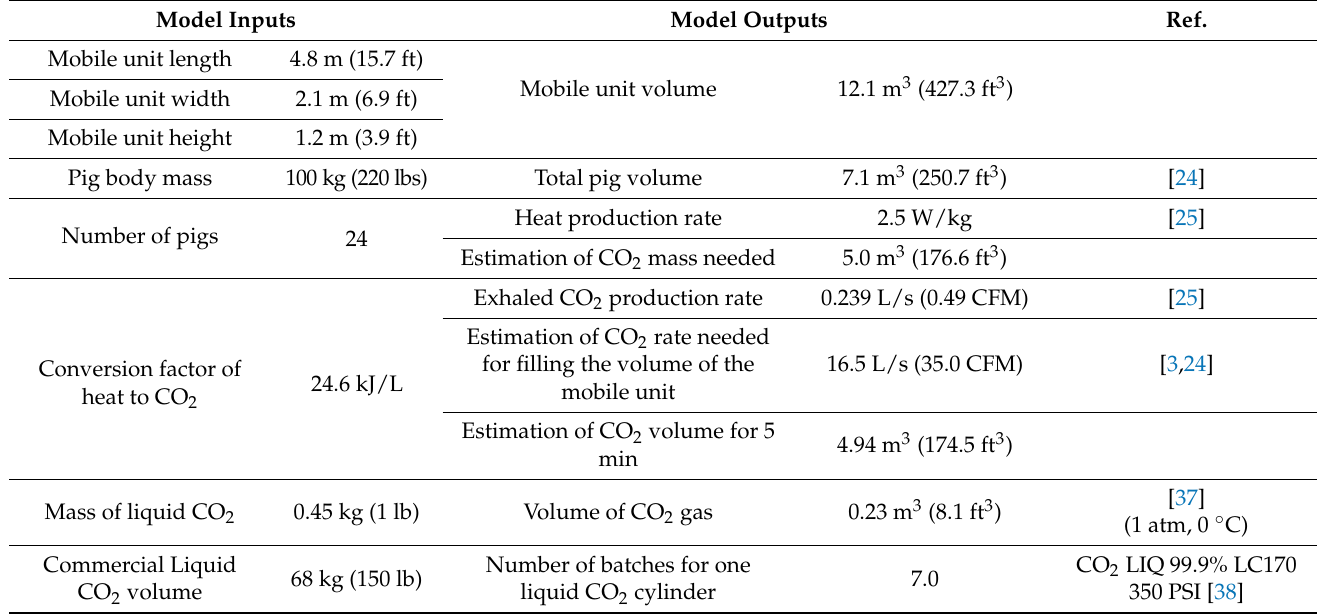
Table 3. Example of CO 2 quantity needed to depopulate a single batch of